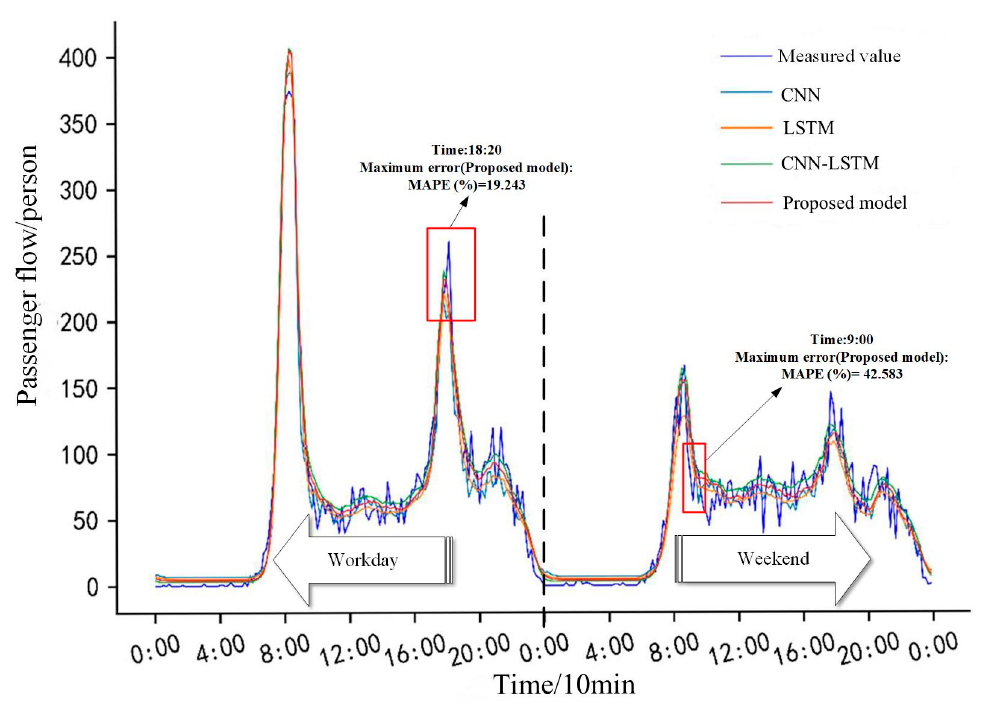
Figure 10. Comparison of passenger flow prediction among models of Xinfeng station.